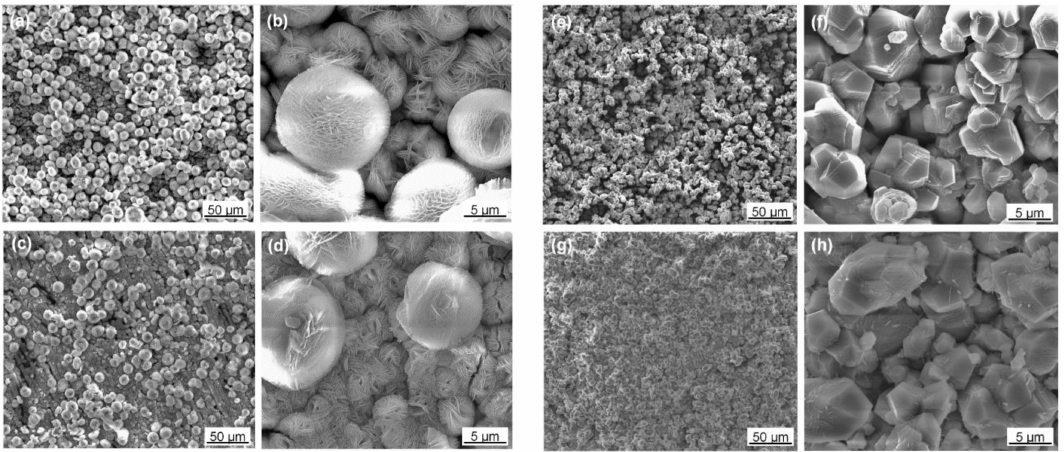
Figure 1. SEM micrographs of samples HT0.5 ( a , b ), HT1 ( c , d ), HT2 ( e , f ) and HT3 ( g , h ) prepared by hydrothermal treatment in 0.5 M NaHCO 3 at 200 ◦ C for 0.5, 1, 2 and 3 h respectively. HT0.5 and HT1 mainly consisted of Mg 5 (CO 3 ) 4 (OH) 2 · 4H 2 O, as it can be seen from XRD